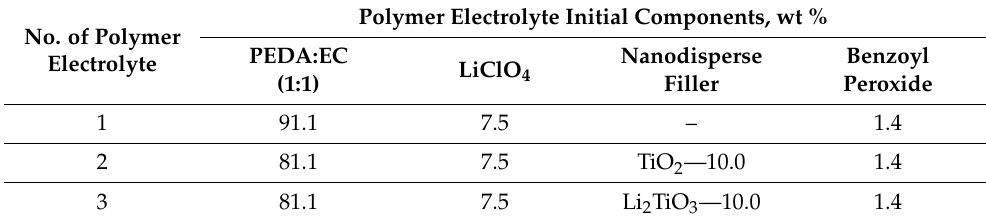
Table 9. Compositions of the polymer electrolytes added with nanoparticles [92].